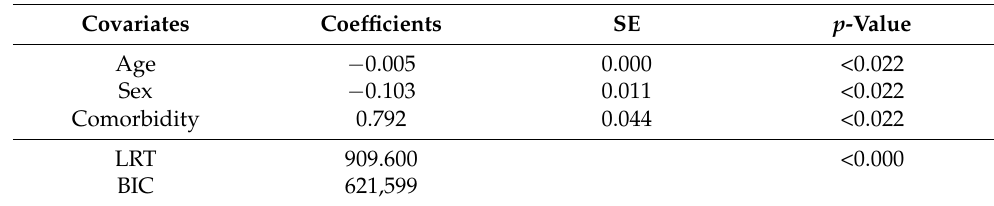
Table 18. Results of Cox-PH model including the coefficients, SE, p -value, LRT, BIC, and CAIC. Covariates Coefficients